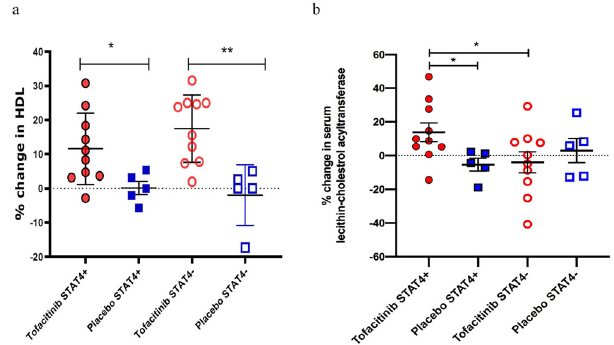
Fig. 3 Tofacitinib modulates HDL levels and function in SLE. a Percent change in serum HDL-C at day 56 compared to day 1 based on STAT4 risk allele status (each circle and square represent individual subject): Results represent * P = 0.037 for the difference between STAT4 risk allele-positive subjects on tofacitinib vs placebo and ** P = 0.002 STAT4 risk allele- negative subjects on tofacitinib vs placebo. Unpaired t test was used. b Percent change in Lecithin – cholesterol acyltransferase (LCAT) concentration at day 56 compared to day 1 based on STAT4 risk allele status (each circle and square represent individual subject): Results represent * P = 0.033 for the difference between STAT4 risk allele-positive subjects on tofacitinib vs placebo and * P = 0.044 for the difference between STAT4 risk allele-positive subjects on tofacitinib vs STAT4 risk allele-negative subjects on tofacitinib. Kruskal – Wallis test (unpaired, nonparametric) was used. Source data are provided as a Source Data fi le. All results represent mean ± SEM, * P < 0.05 ** P < 0.01, and are based on tofacitinib n = 20, placebo n = 10. Two-tailed tests were used where appropriate. No adjustments were made for multiple